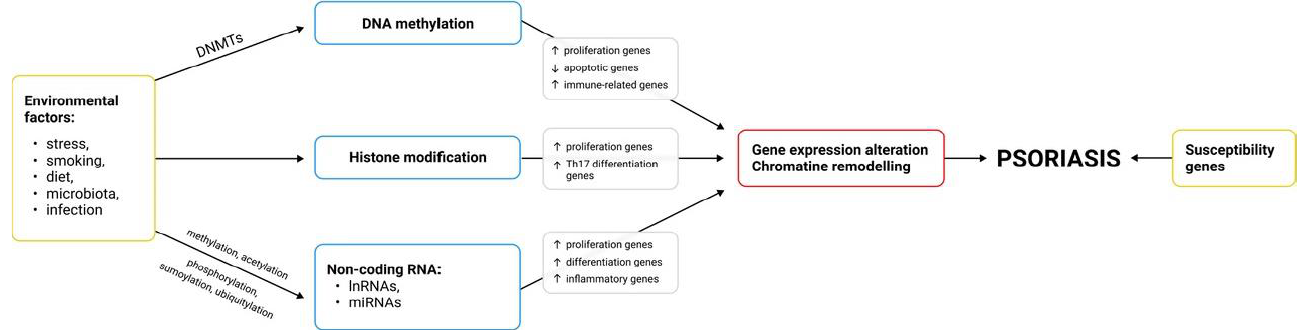
Figure 1. Epigenetic modifications in psoriasis: DNA methylation, histone modifications and non-coding RNAs.